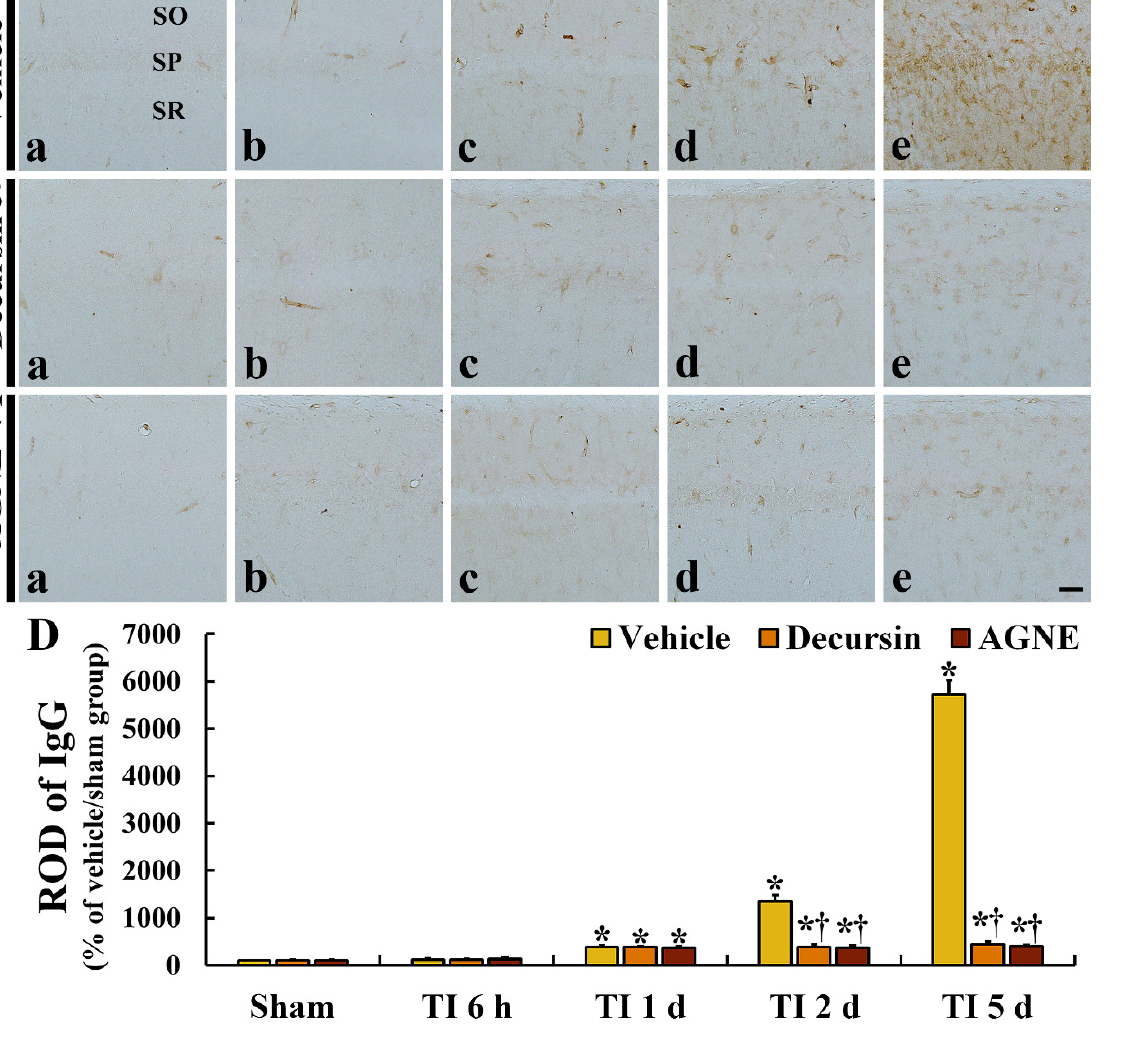
Figure 6. ( A – C ) IgG immunoreactivity in CA1 of the vehicle treated ( Aa – Ae ), decursin treated ( Ba – Be ), and AGNE treated ( Ca – Ce ) groups at 6 h (all b ), 1 day (all c ), 2 days (all d ), and 5 days (all e ) after TI. In the TI/decursin and TI/AGNE groups, IgG immunoreactivity at 2 and 5 days after TI is significantly lower than that in the TI/vehicle group. ( D ) Relative optical density (ROD) of IgG immunoreactivity in CA1. Scale bar = 100 μ m. The bars indicate the means ± SEM ( n = 7 at each time after TI, * p < 0.05 vs. sham/vehicle group, # p < 0.05 vs. TI/vehicle, and † p < 0.05 vs. corresponding TI/vehicle group).